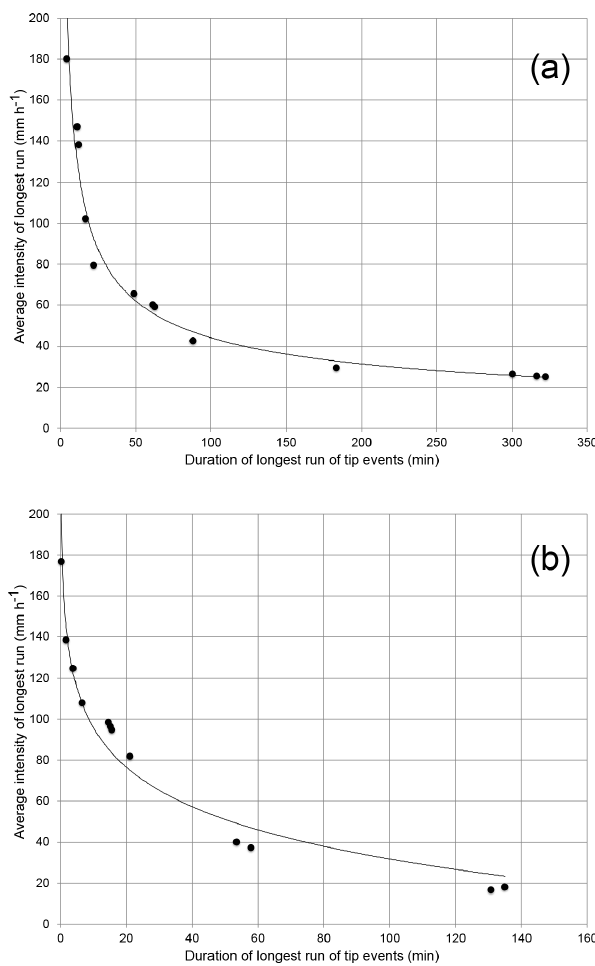
Figure 6. Relationships between the average intensity of the longest run of ITTs having durations from 0.1 to 5min and the duration of the longest such run. Locations: (a) MM, (b) FG. The solid lines are fitted regression equations (see text for details). Note the rapid rise in intensity for bursts with durations less than about